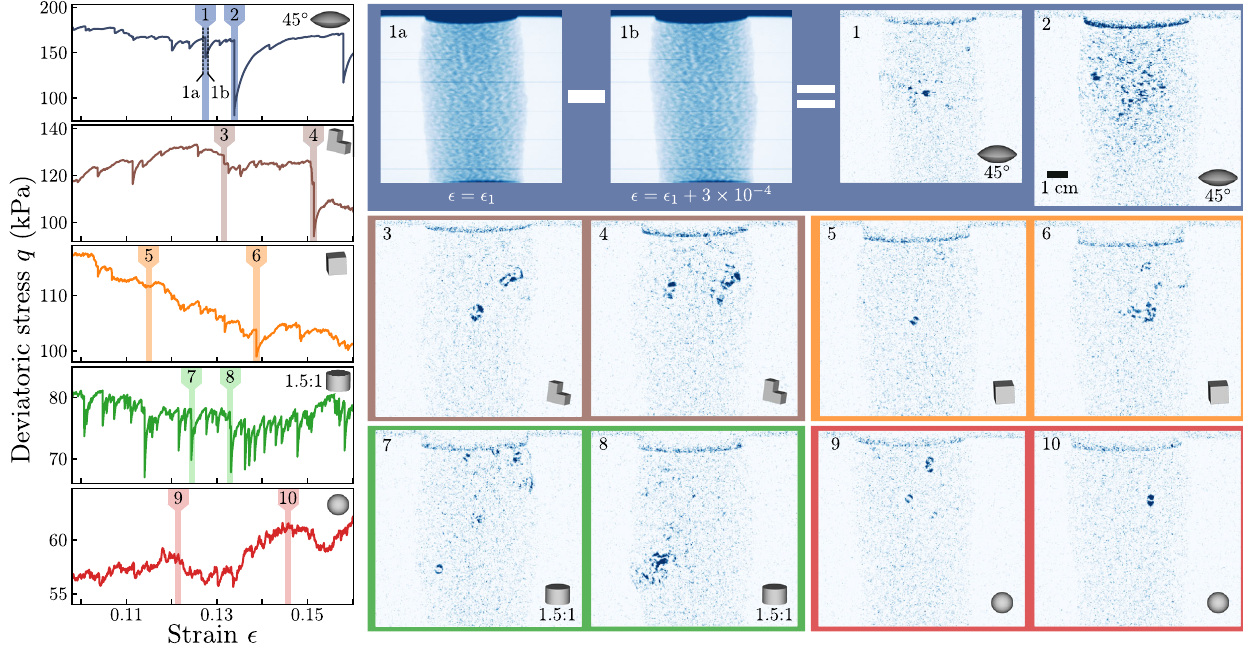
FIG. 2. Localized slips revealed by x-ray videography. Stress-strain data (left) for representative particle shapes, with numbered vertical bars that indicate the strains at which the x-ray data shown on the right were taken. Subtracting successive x-ray frames reveals the particle rearrangements that cause sudden stress drops in q ð ϵ Þ . We show this explicitly for the first labeled stress drop event, where 1a and 1b are the raw x-ray frames subtracted to obtain difference image 1. The dark horizontal band at the top of each x-ray difference image reflects the top plate ’ s motion during compression. For a sense of scale, the dark blue regions in the difference images for events 5 and 10 each correspond to a single particle shifting position by roughly a particle diameter. For clarity, the shaded bars in the stress-strain curves are plotted 5 times wider than the strain window captured by a single x-ray frame. The x-ray images for events 2 – 10 are all shown at the same scale, enabling direct